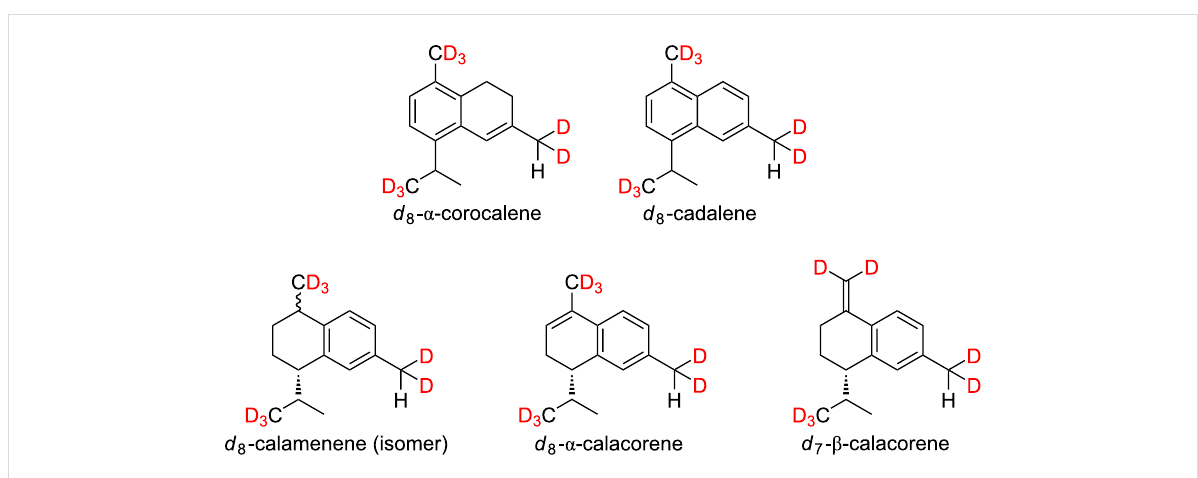
Figure 6: Expected labeling patterns of deuterium-labeled, aromatic sesquiterpenes after administration of [6,6,6- 2 H 3 ]-(±)-mevalonolactone ( d 3 -MVL) to isolated exocarp of grape berries (Lemberger cultivar).